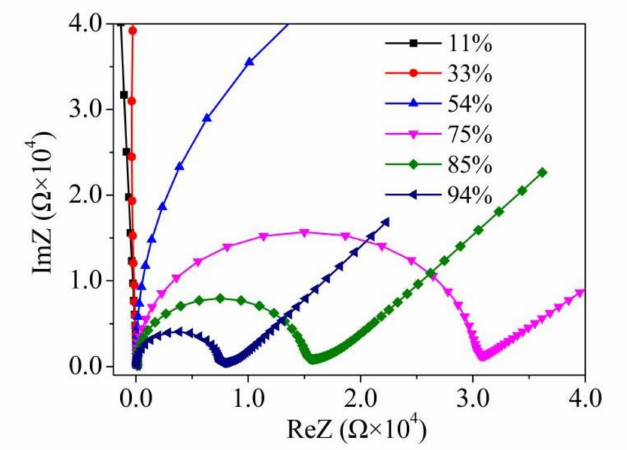
Figure 9. Complex impedance diagrams of the MAPbI 3 -based sensor with different RH levels.